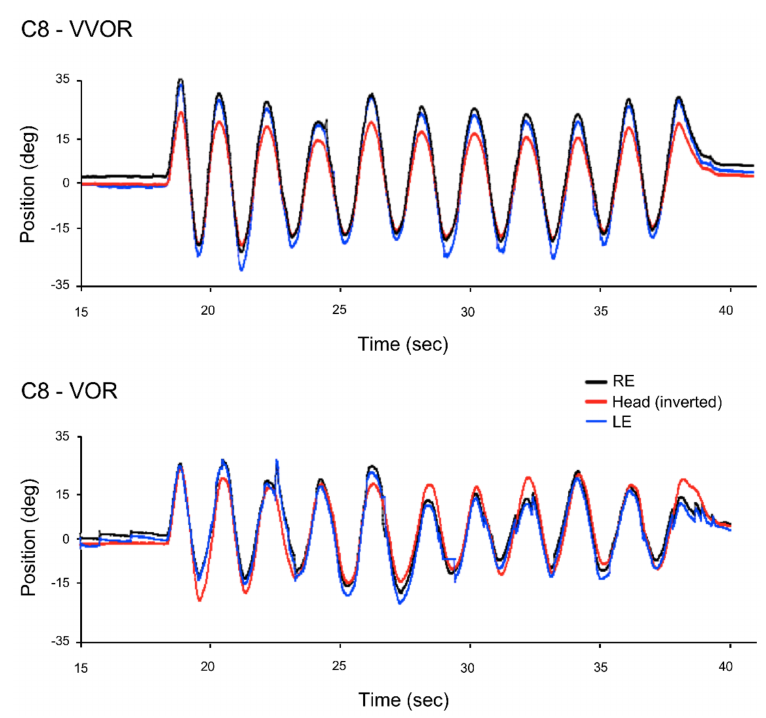
Figure 1. Right (RE), left (LE) eye and head position traces in the light (VVOR, above) and in the dark (vestibulo-ocular reflex (VOR), below) for the complete testing period for C8, one of the control participants. The values of the head’s position coordinates are inverted so that the eye and head curves can be